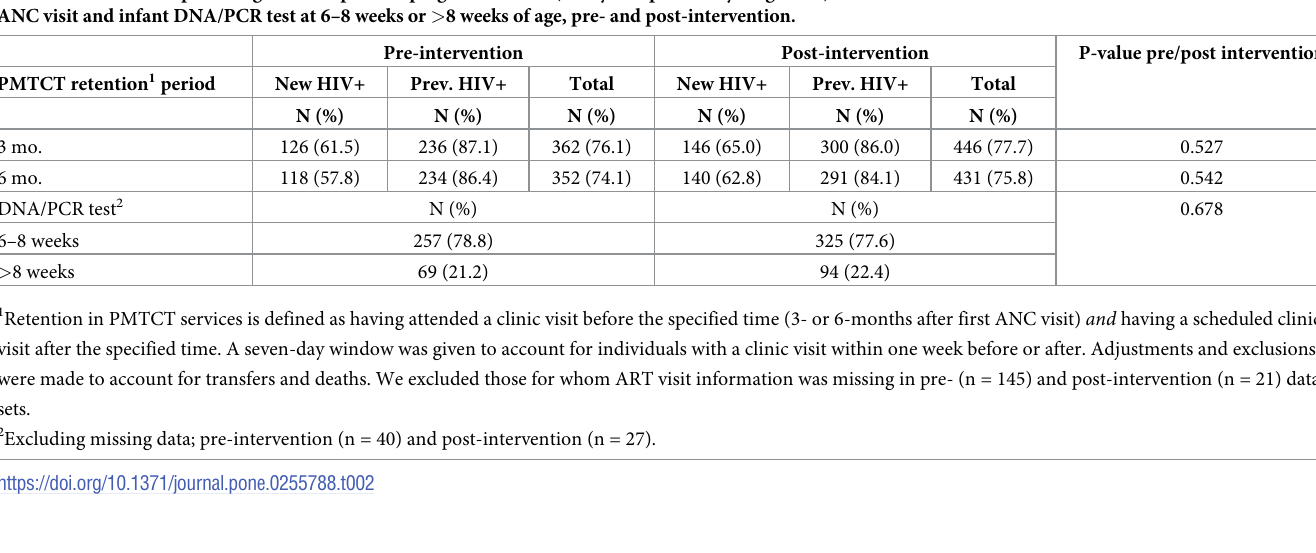
Pre-intervention